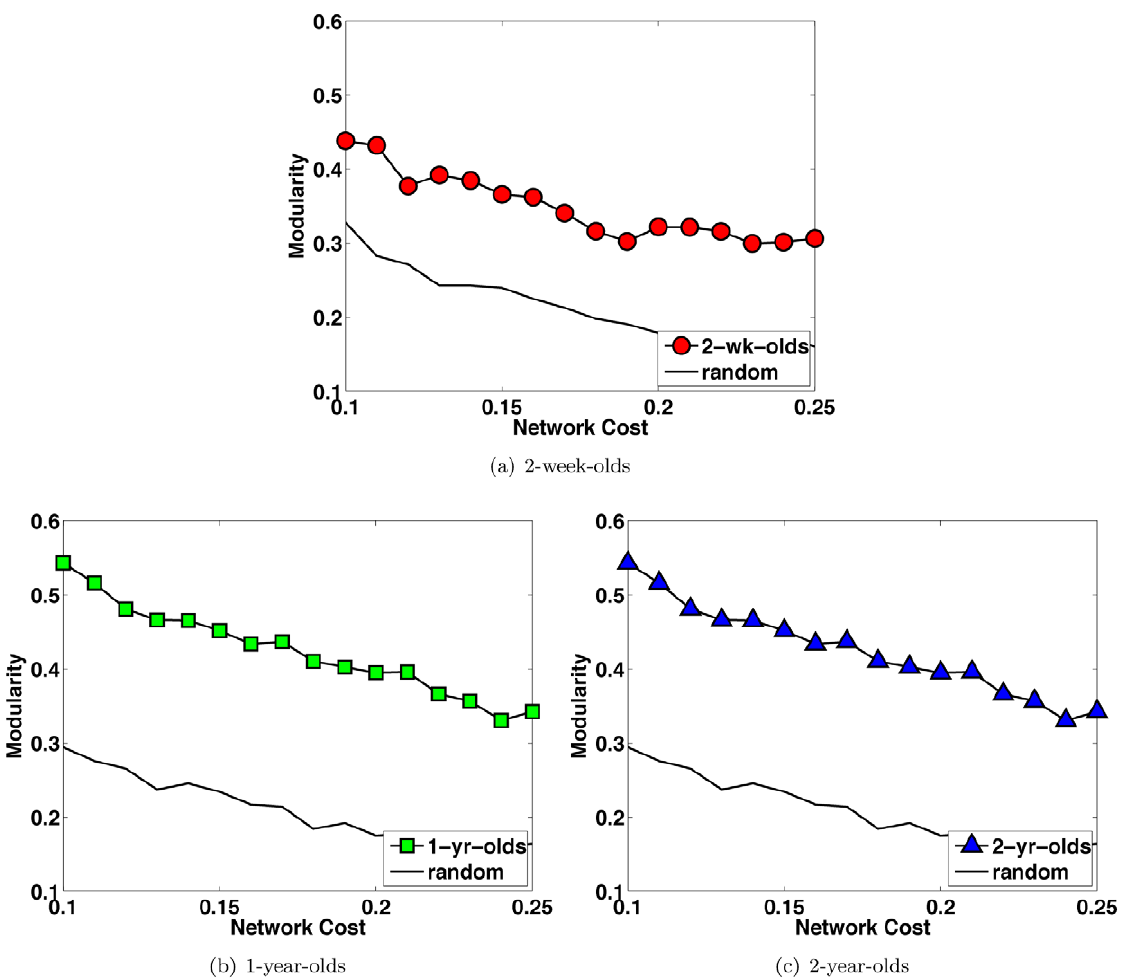
Figure 7. Nonrandom Modularity. Comparing the modularities [15,16] of the brain networks with comparable random networks indicates non- random network modularity.